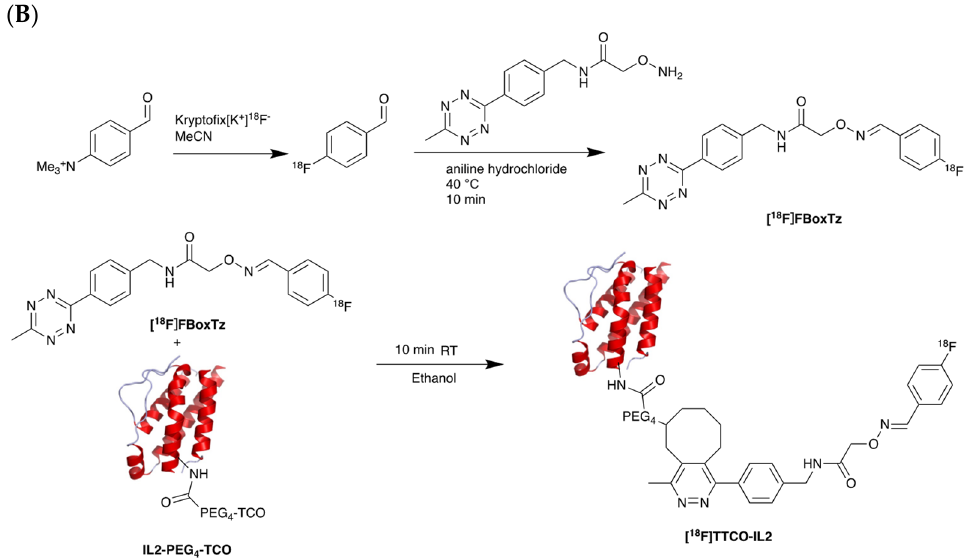
Figure 7. Procedure for radiolabelling of interleukin-2 (IL-2). ( A ) [ 18 F]SFB radiolabelling of IL-2 starting with nucleophilic fluorination of 4-(Ethoxycarbonyl)-N,N,N-trimethylbenzenaminium. ( B ) [ 18 F]Box-Tz radiolabelling of IL-2 enabled by the click chemistry between TCO labelled IL-2 tetrazine functionalised [ 18 F]FBox-Tz.